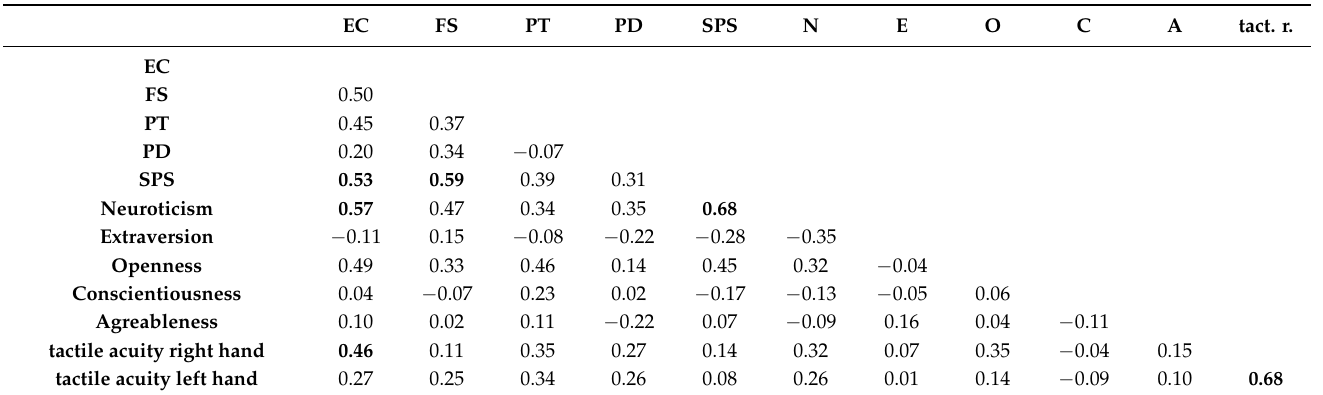
Table 2. Correlation matrix of personality questionnaires and tactile performance (Pearson, significant results in bold).